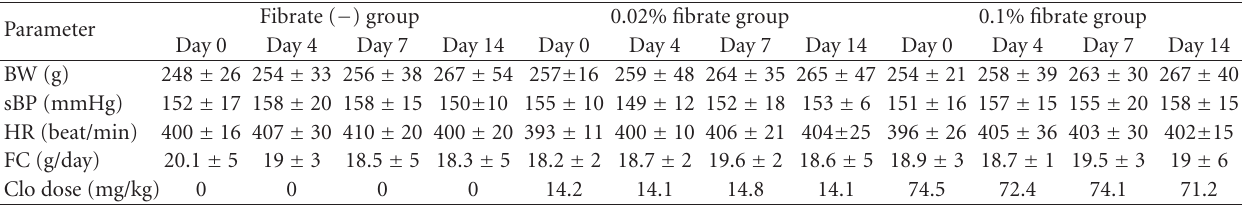
Table 1: Systemic change and estimated dose of clofibrate in anti-Thy1 nephritis rats.